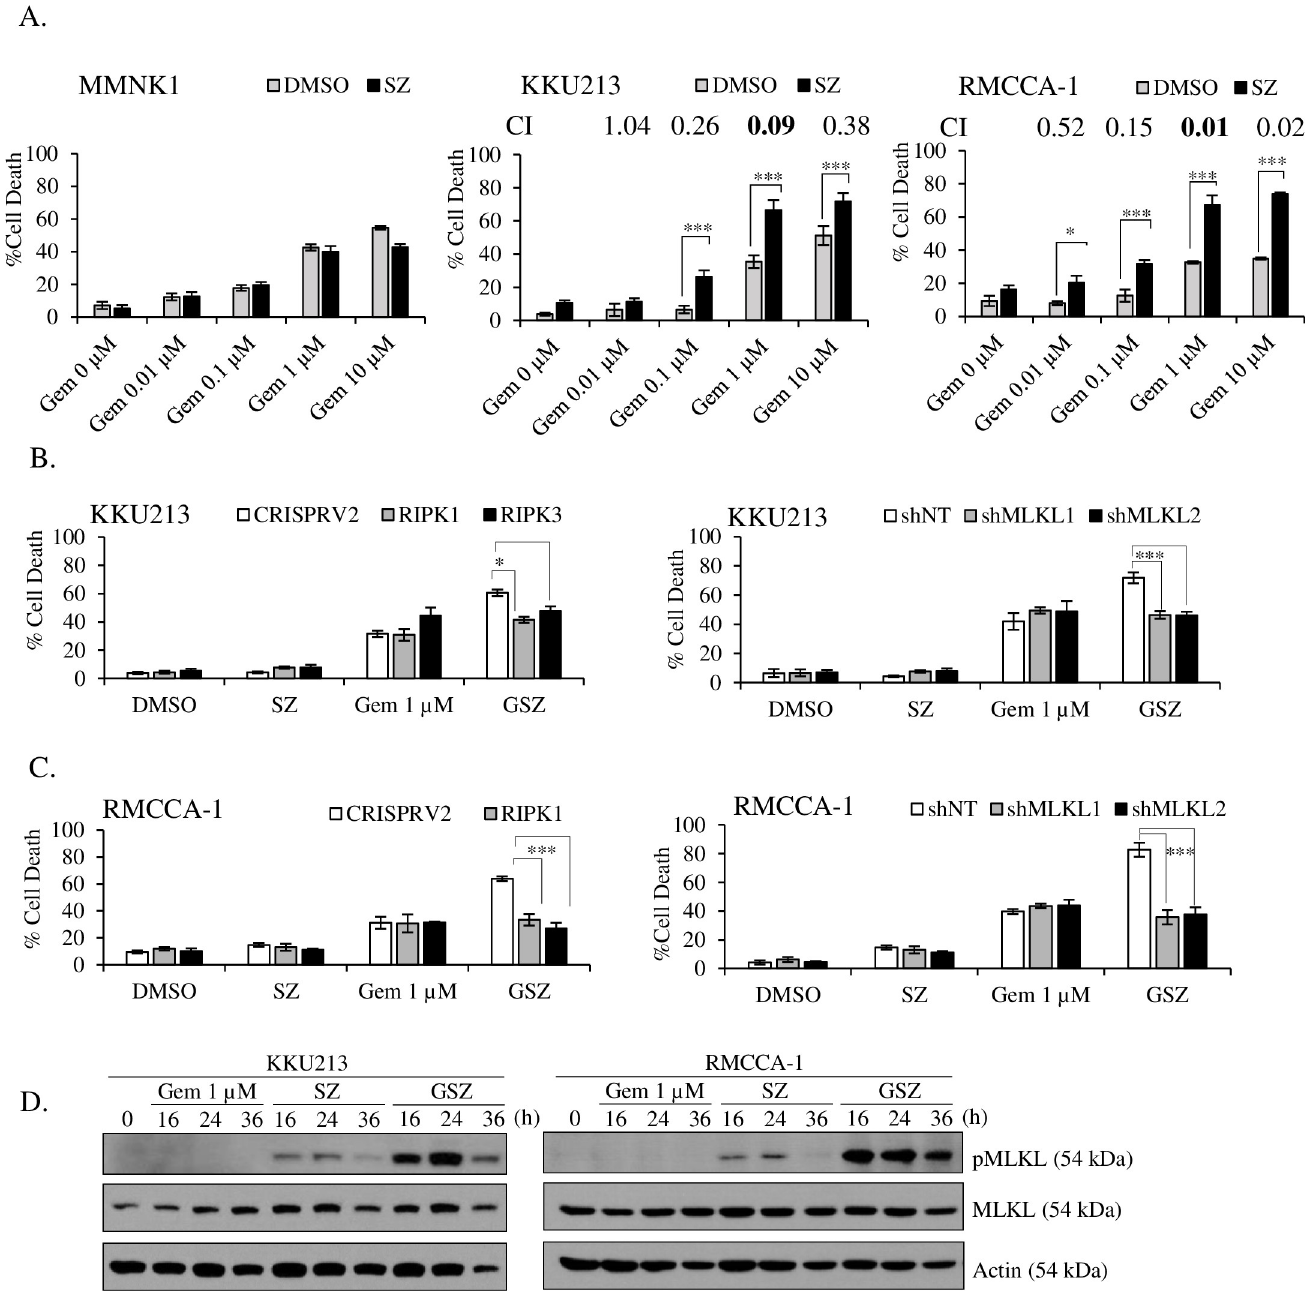
Fig 4. Smac mimetic and gemcitabine synergistically trigger necroptosis upon caspase inhibition. (A) MMNK1, KKU213, and RMCCA-1 were pretreated with DMSO or 5 nM Smac mimetic for 2 h in the presence of 20 μ M zVAD-fmk followed by addition of 0.01, 0.1, 1, or 10 μ M gemcitabine for 72 h (MMNK1 and KKU213) and 48 h (RMCCA-1). RIPK1 and RIPK3 knockout or MLKL knockdown (B) KKU213 and (C) RMCCA-1 cells were pretreated with DMSO or 5 nM Smac mimetic and 20 μ M zVAD-fmk for 2 h followed by treatment with 1 μ M gemcitabine for 72 h (KKU213) and 48 h (RMCCA-1). Cell death was determined